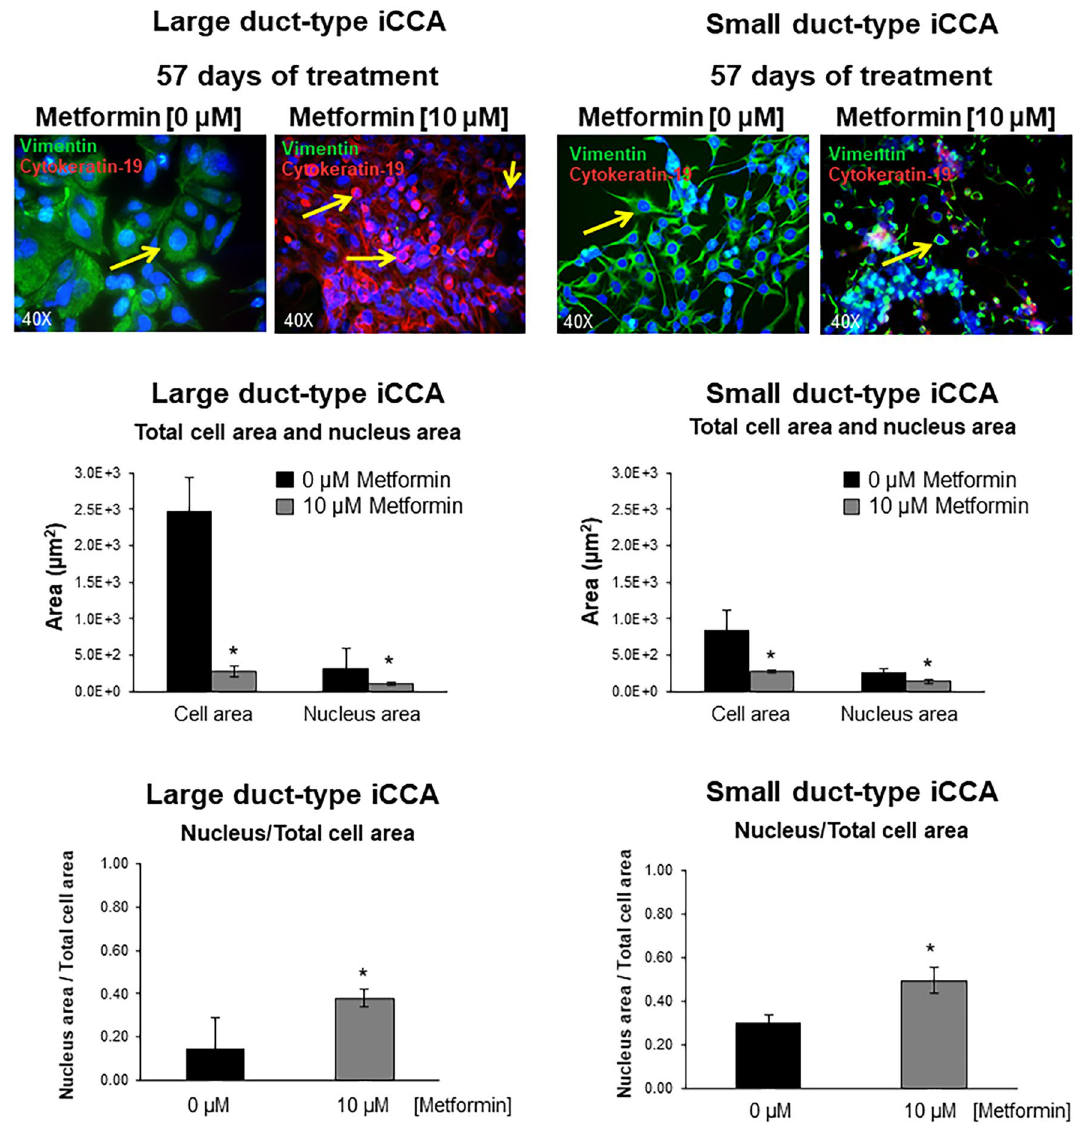
morphology after exposure to Metformin 10 µM for 57 days, was observed. Indeed, treated cells displayed smaller nuclei, smaller total cell area and a smaller nucleus area / total cell area ratio compare to controls; these changes being consistent with a trend toward Mesenchymal-Epithelial transition 34 . * p < 0.05 versus controls. Data represent mean ± SD of N = 3 independent